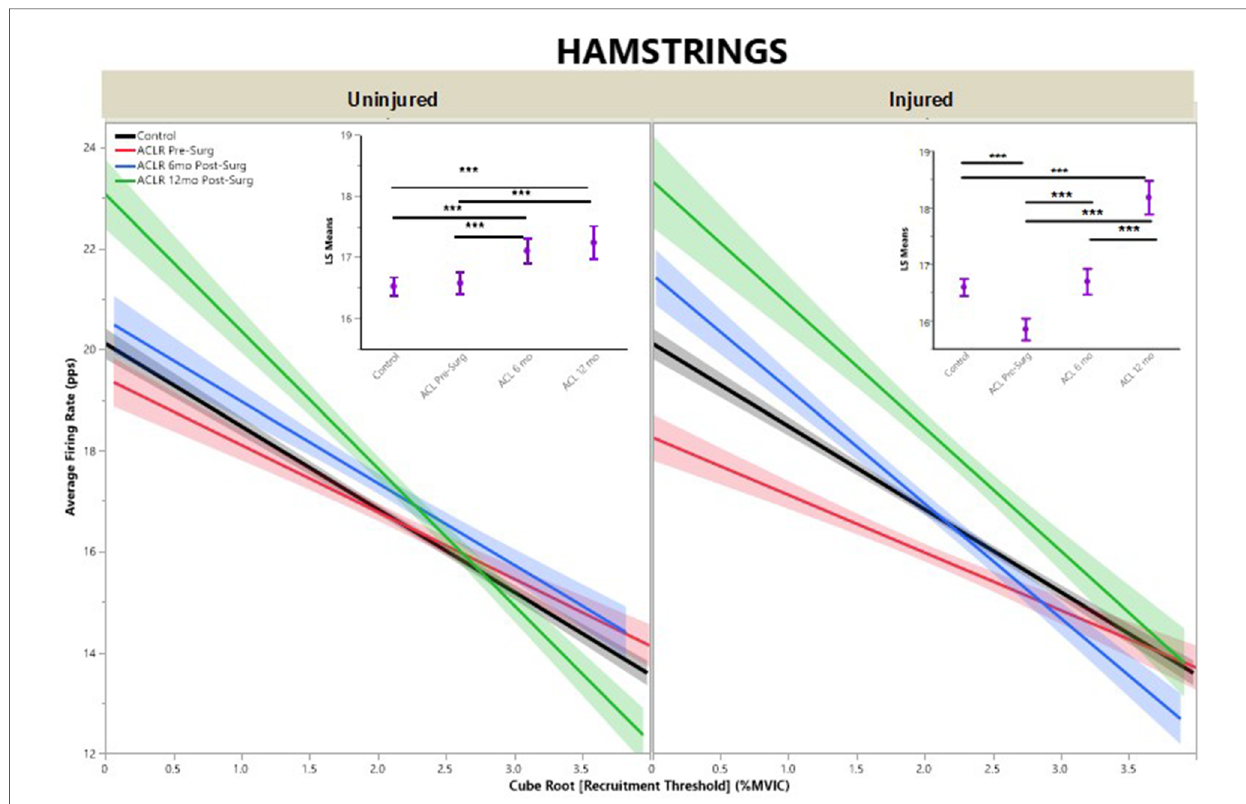
FIGURE 4 Hamstrings average fi ring rate by group for uninjured and injured limbs. Average fi ring rate represents motor unit fi ring frequency. (Insets) Least means square ANOVA demonstrates signi fi cant differences of MUAP between groups. (* denotes p <0.05; *** denotes p <0.001; line shading and error bars denote 95% con fi dence intervals of the